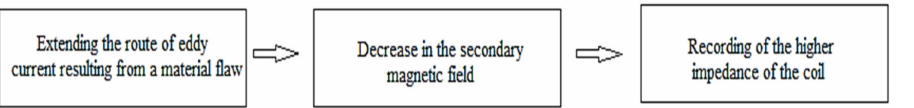
Figure 1. The sequence of phenomena while detecting inconsistency in a material. Source: own, based on